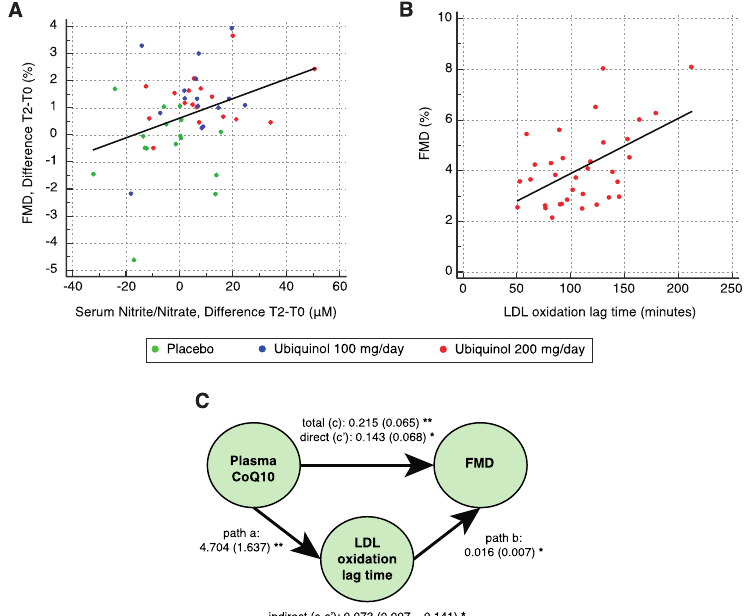
Figure 3. ( A ) Scatterplot showing the correlation between serum nitric oxide (NO) and FMD variations at the three timepoints ( n = 48). ( B ) Scatterplot showing the correlations between low- density lipoprotein (LDL) oxidation lag time and FMD in the ubiquinol 200 mg/day group. ( C ) Results of mediation analysis of the effects of plasma CoQ10 on FMD mediated by LDL susceptibility to oxidation. *, p < 0.05; **, p < 0.01 for standardized bootstrapped (10,000 samples) total, direct, and indirect effect size. In brackets, are reported the standard errors for total and direct effects, and the 95% CI for indirect effect. The mediation procedure is described in Methods, paragraph